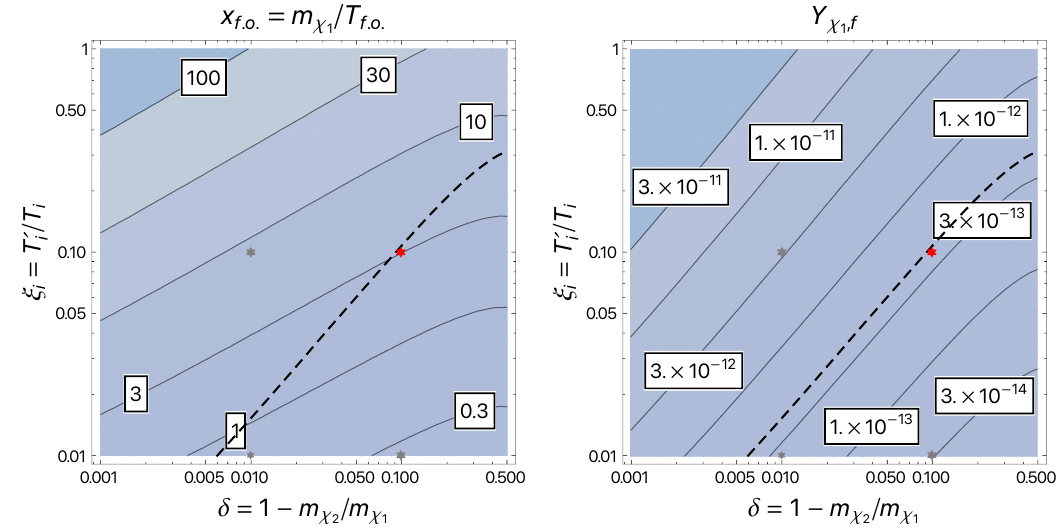
(right panel) obtained from the analytical solution 1 ,f = 1 TeV, as well as g 1 g 2 /m 2 = 1 / (4 TeV ) 2 . The A 1